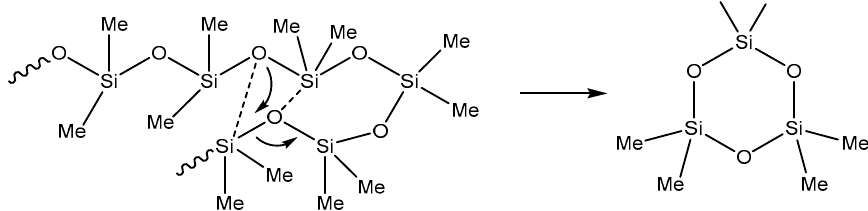
Figure 1. The mechanism of formation of hexamethyltricyclosiloxane. Adapted from Ref. [11], copyright 2001, with permission from Elsevier.